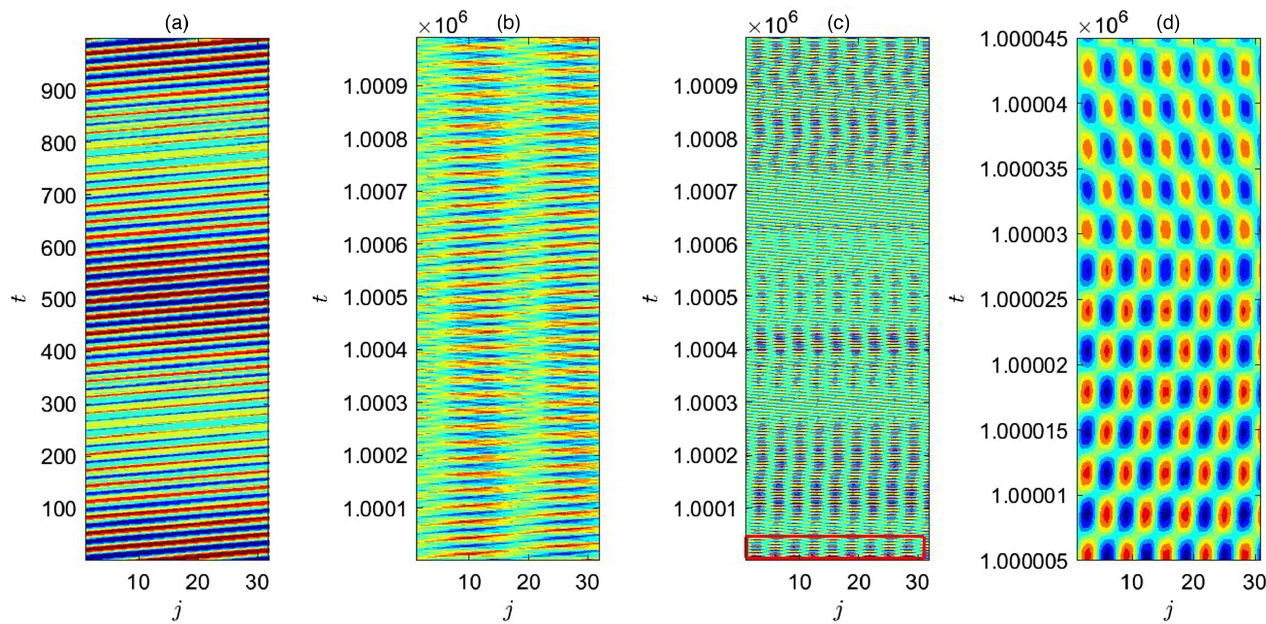
FIG. 9. Color map of the displacement q j ð t Þ for ϵ ¼ 0 . 02 : (a) initial traveling wave, 0 < t < 1000 , (b) standing wave structure in thermal equilibrium, 10 6 < t < 10 6 þ 1000 , (c) ˜ q j ð t Þ , displacement after removing wave numbers k ¼ 1 ; … ; 4 ; 7 ; … ; N , (d) closer look at the boxed region in (c).